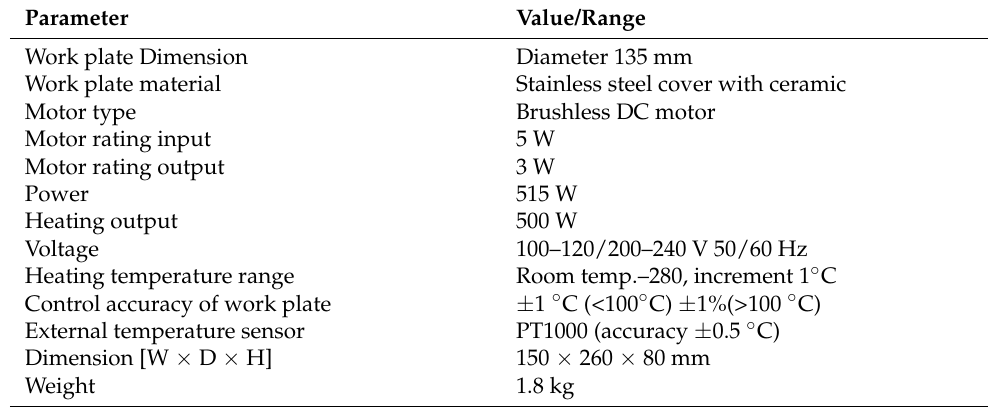
Table 1. Specifications of MS-H280-Pro Round ceramic coated Steel